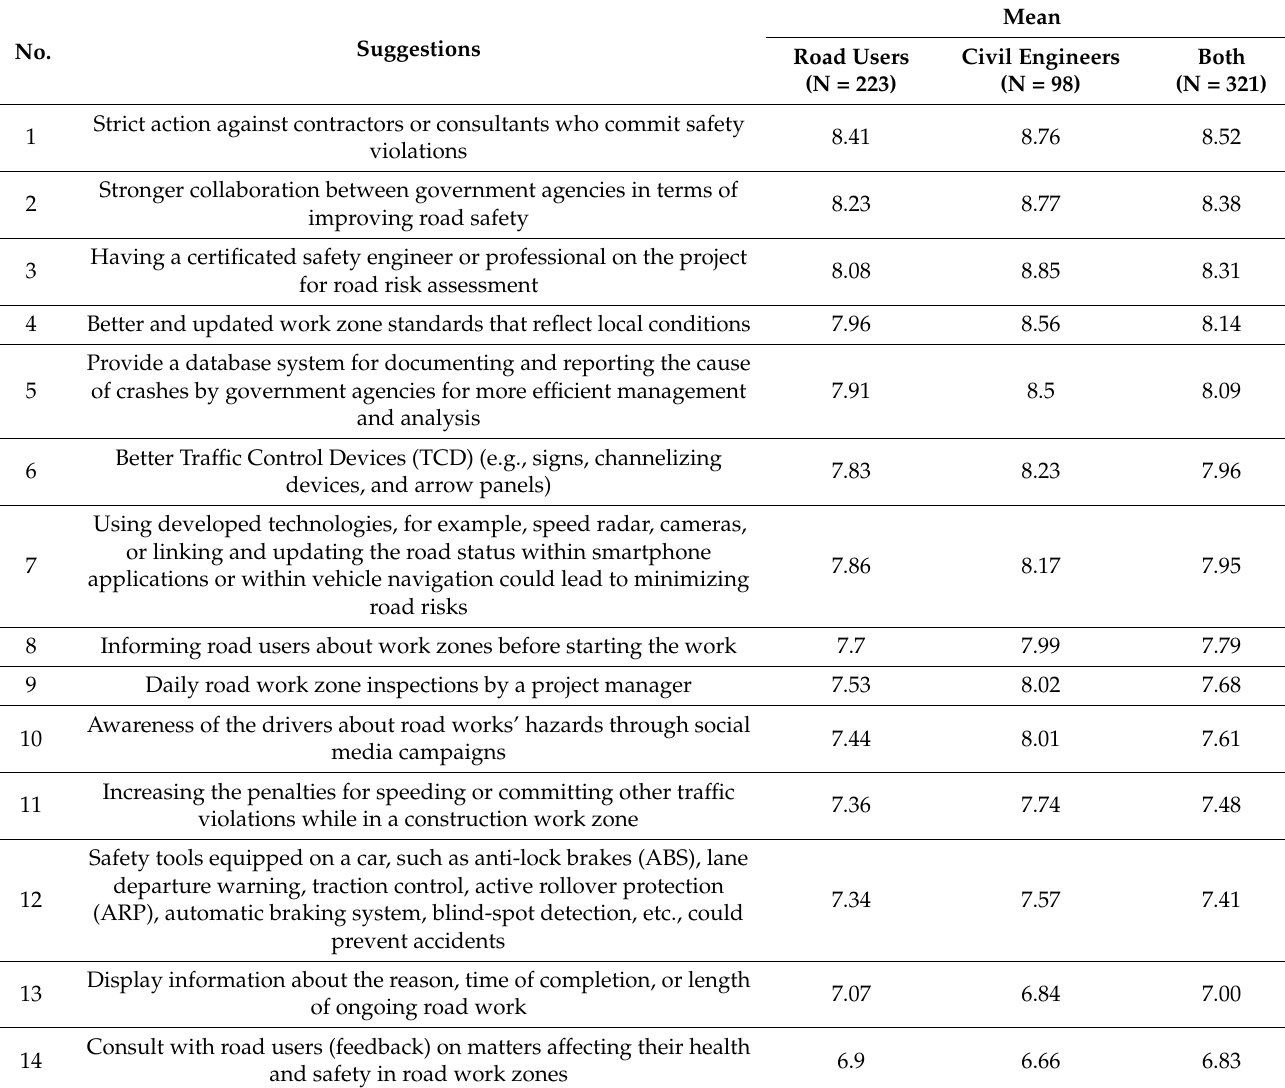
Table 5. Suggestions to improve road safety in the work